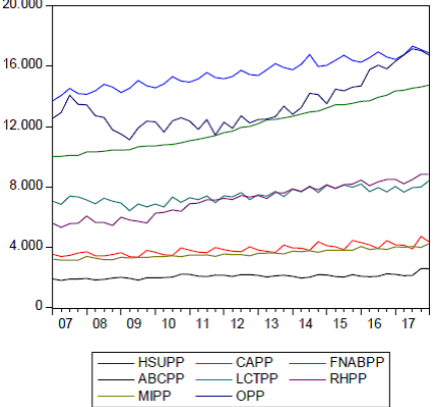
Figure 5. Sub-categories of durable goods consumption Figure 6. Sub-categories of non-durable goods consumption